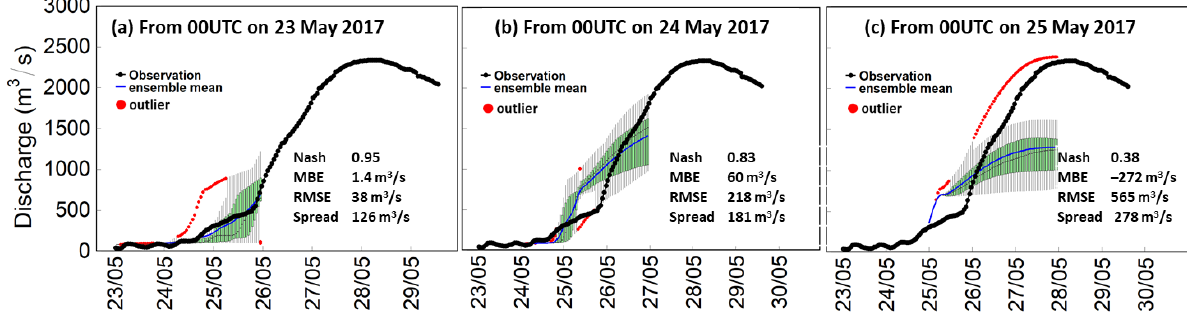
Figure 14. Comparison of model-simulated ensemble discharges with observation (m 3 /s) at the Putupaula gauging station for each forecasting time starting from 00 UTC on ( a ) 23 May, ( b ) 24 May, and ( c ) 25 May 2017.